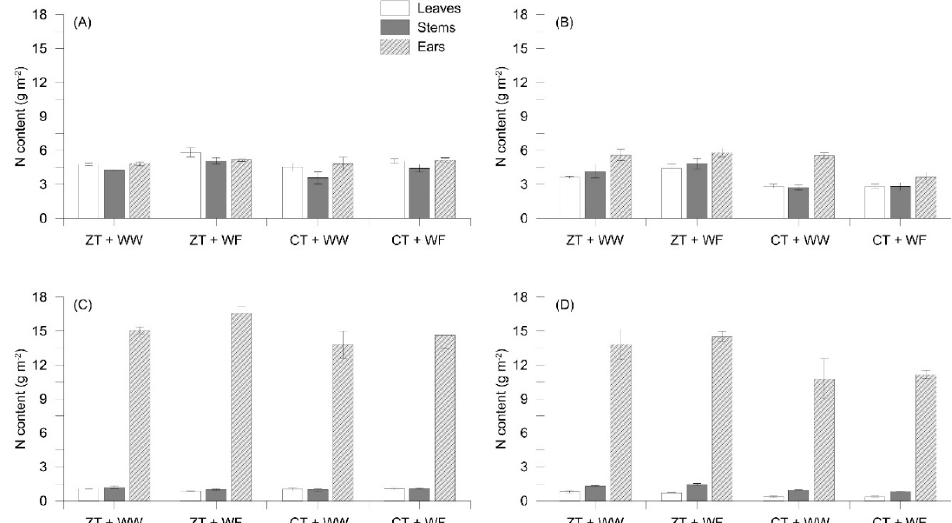
Figure 3. N concentration (g kg − 1 ) in leaves, stems and ears at DC71 and DC91 phenological stages of durum wheat in 2016 (A and C, respectively) and 2017 (B and D, respectively) cropping seasons. Treatments: CT, conventional tillage; ZT, zero tillage; WW, durum wheat monocropping; WF, durum wheat-faba bean rotation. Data are averages ± standard errors of n = 3 independent replicates. At harvest, di ff erences among the years and treatments reduced drastically. Averaging over treatments, the N concentration generally decreased in leaves (by 66% and 62% in 2016 and 2017, respectively) and stems (by 60% and 45% in 2016 and 2017, respectively), while remained substantially − 1 − 1 unchanged in the ears (17.9 and 16.1 g kg in 2016; 15.3 and 15.7 g kg in 2017) (Figure 3). The N content was confirmed to be higher in 2016 and from post-anthesis to grain filling, it increased significantly in the ears (on average by 3-fold and 2.5-fold increase in 2016 and 2017, respectively) while it reduced in the stems (on average by 75% and 69% in 2016 and 2017, respectively) and leaves (on average by 80% and 84% in 2016 and 2017, respectively) (Figure 4). ZT always induced significantly higher N contents (Figure 4, Table 3).